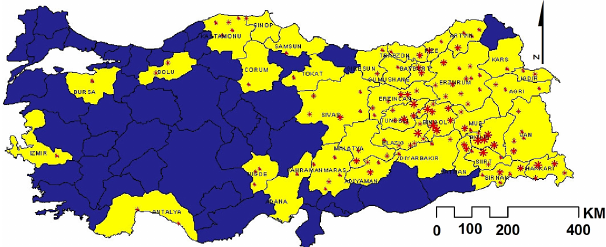
Fig. 3. Avalanche record map of Turkey (yellow color refers avalanche observed cities and red stars refer to recorded avalanche locations, Source: